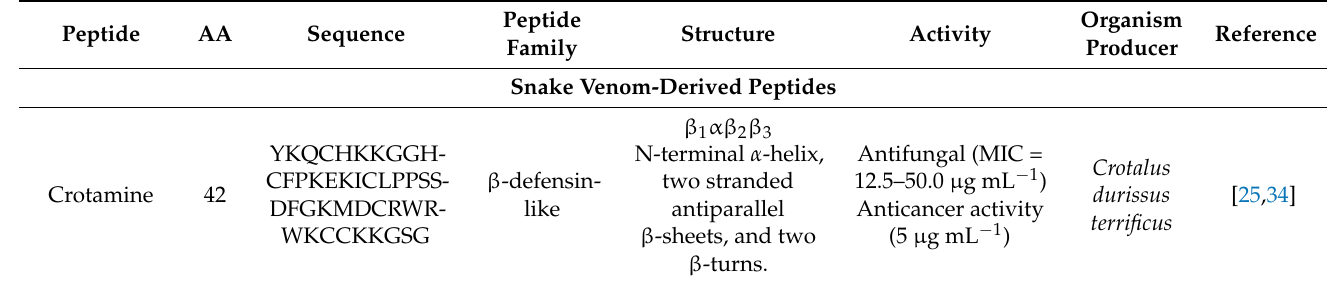
Figure 1. Families of venom-derived peptides from South American organisms. Schematic representation of the venom producers from South America and main peptide families found in their venoms, such as β -defensins (e.g., crotamine), cathelicidins (e.g., crotalicidine), ICK peptides (e.g., psalmotoxin 1), α -toxins (e.g., Ts1), β -toxins (e.g., Ts3), mastoparans, and chemotactic peptides (e.g., polybia-CP). This figure was created with BioRender.com. Table 1. Structural features and biological activities of venom-derived peptides from South Amer- ican organisms. Extended overview of the number of amino acids (referred to as AA), sequence, peptide family, structure, biological activity, and producer organism of the venom-derived peptides. n.e. = not